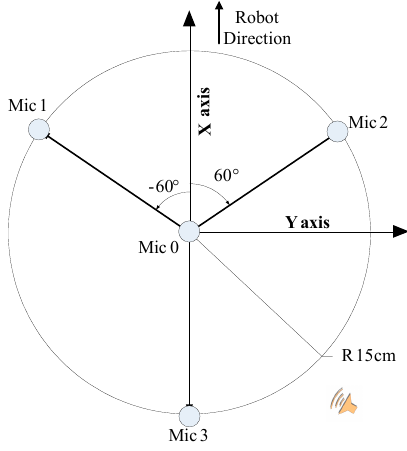
Figure 3. Arrangement of the 4-chnanel microphone array.